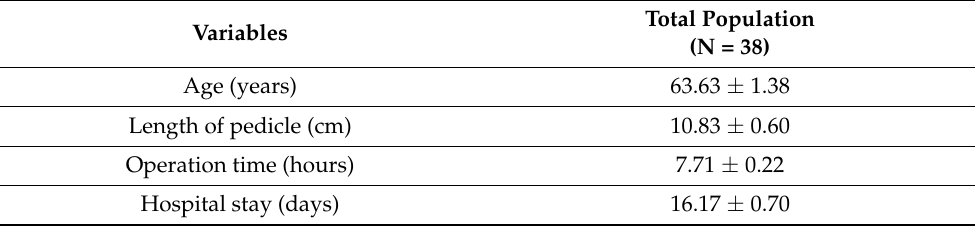
Table 1. Descriptive continuous variables in total study population. Results represented as mean ±